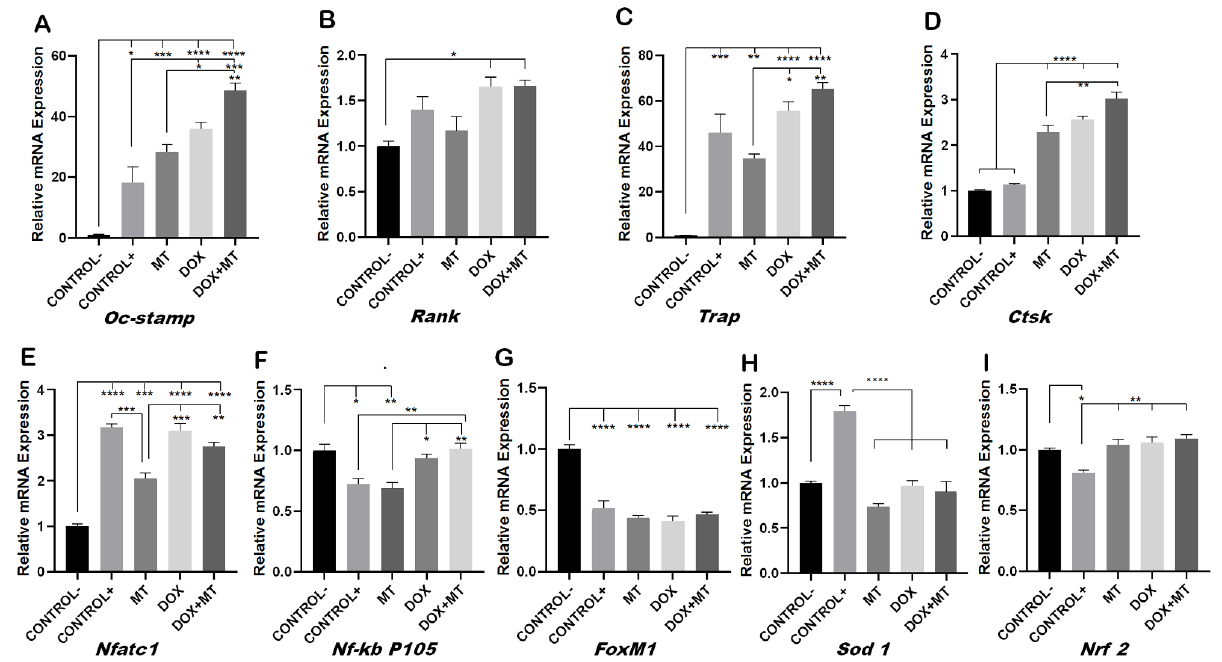
Figure 6. Effect of MitoTEMPO on doxorubicin-induced osteoclast differentiation and oxidative stress markers. RAW264.7 cells were cultured for 4 days with M-CSF (30 ng/mL) and RANKL (50 ng/mL) and treated with MitoTEMPO (MT) and Doxorubicin (DOX) alone or together. Levels of expression for Oc-stamp ( A ), Rank ( B ), Trap ( C ), Ctsk ( D ), Nfatc1 ( E ), Nf-kb p105 ( F ), FoxM1 ( G ), Sod1 ( H ) and Nrf 2 ( I ) were analyzed by qPCR. One-way ANOVA, Tukey ’ s multiple comparisons test, * — p ≤ 0.05, ** — p ≤ 0.01, *** — p ≤ 0.001, **** — p ≤ 0.0001.